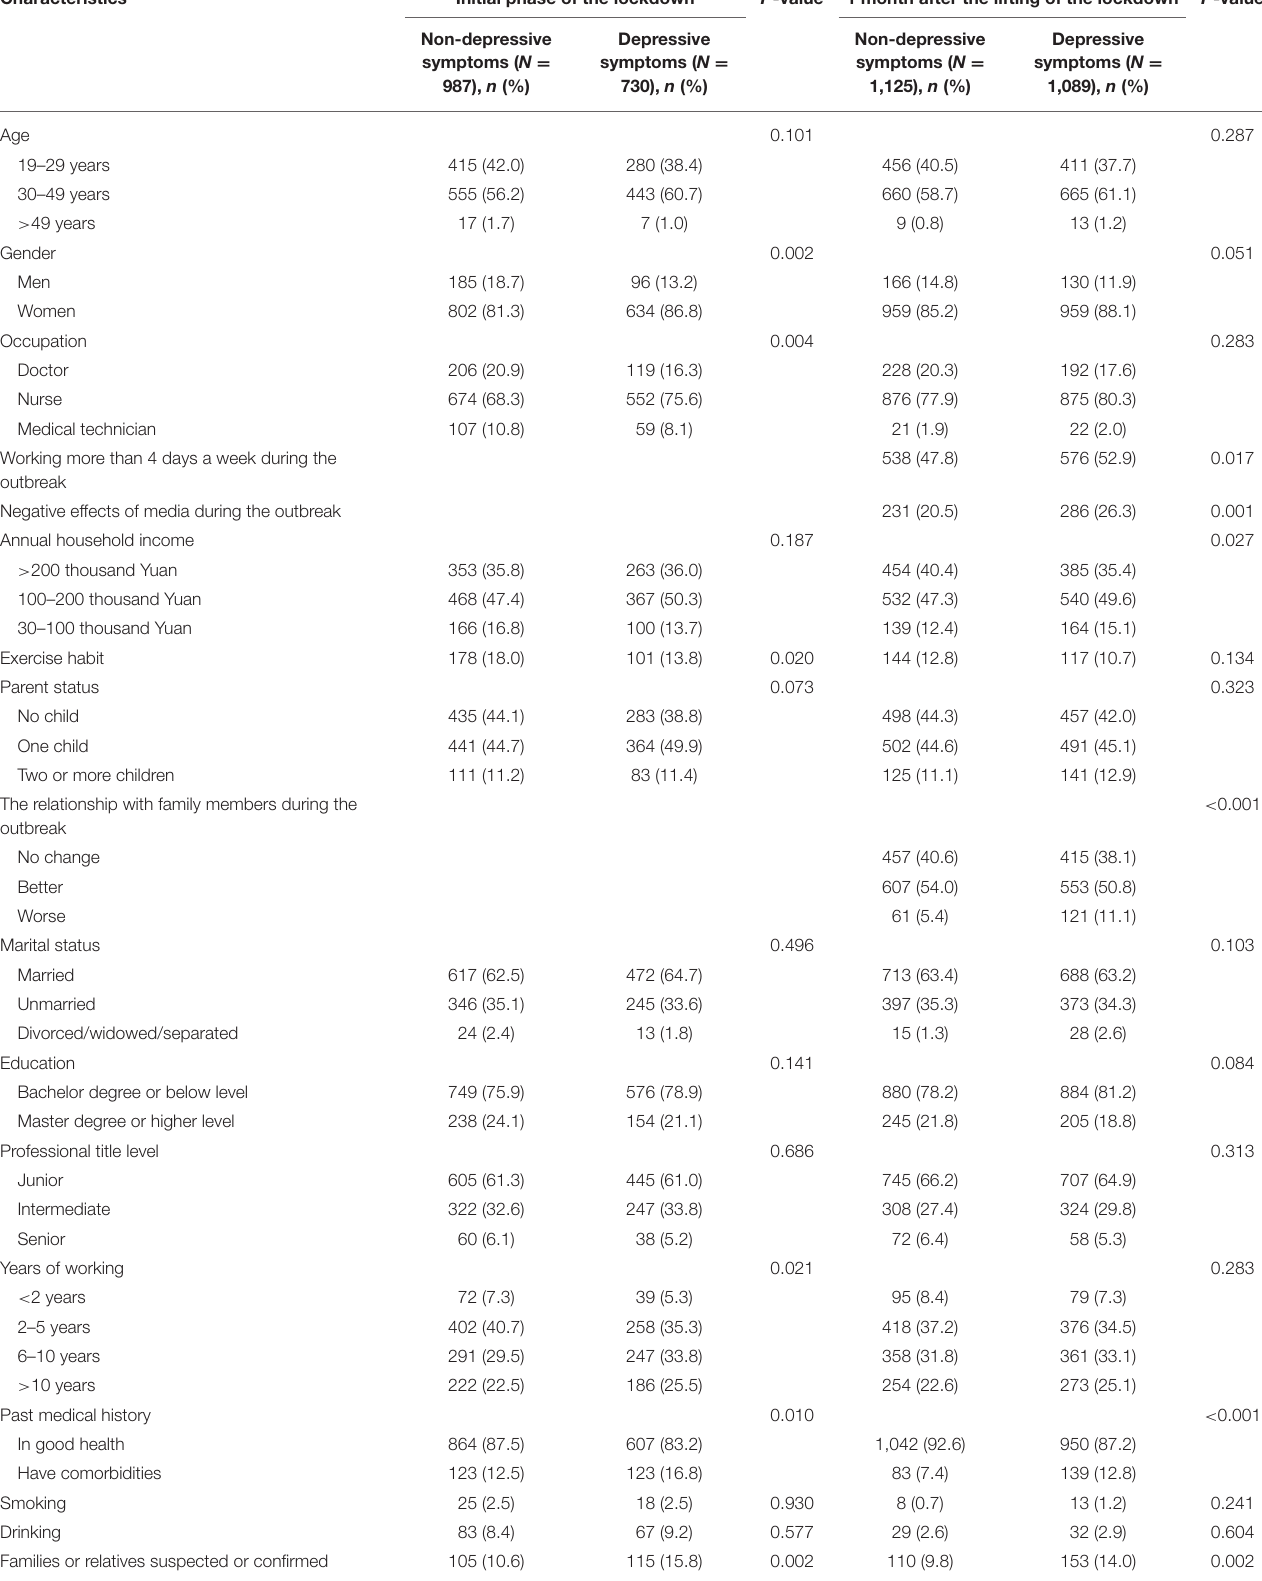
TABLE 3 | Sociodemographic characteristics associated with depressive symptoms in front-line HWs in two phases.